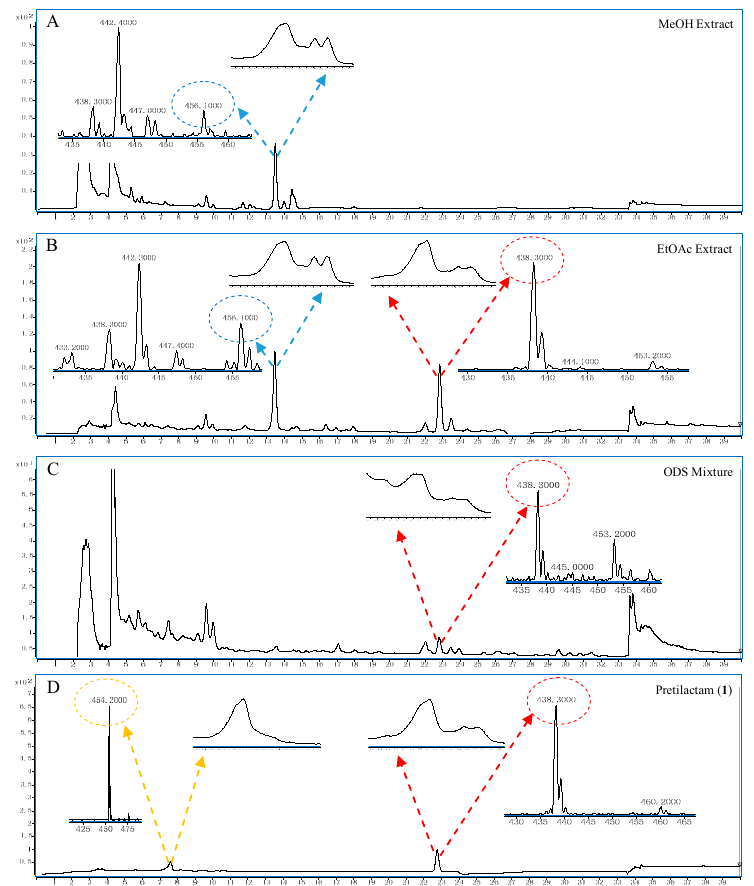
Figure 2. LC-MS for putative polyene macrolactam and the purified polyene macrolactam pretilactam ( 1 ). ( A ) A molecular ion m / z 456 [M + H] + appeared at 13.5 min in the MeOH extract of ATCC 31565. ( B ) Two molecular ions m / z 456 [M + H] + and 438 [M + H] + appeared at 13.5 and 22.7 min, respectively,